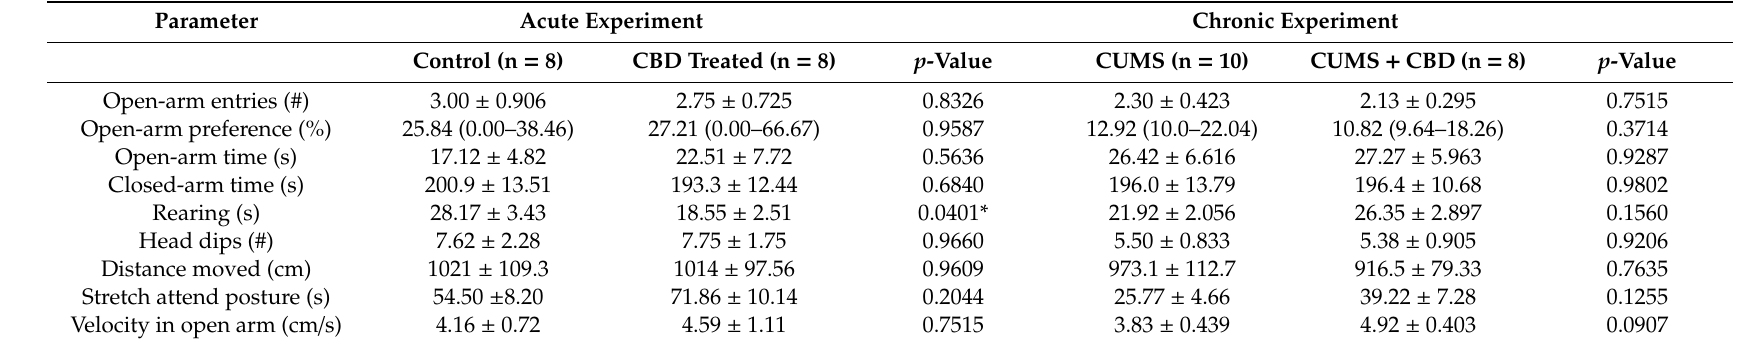
Table 2. Behavioral characteristics of rats in the elevated plus maze